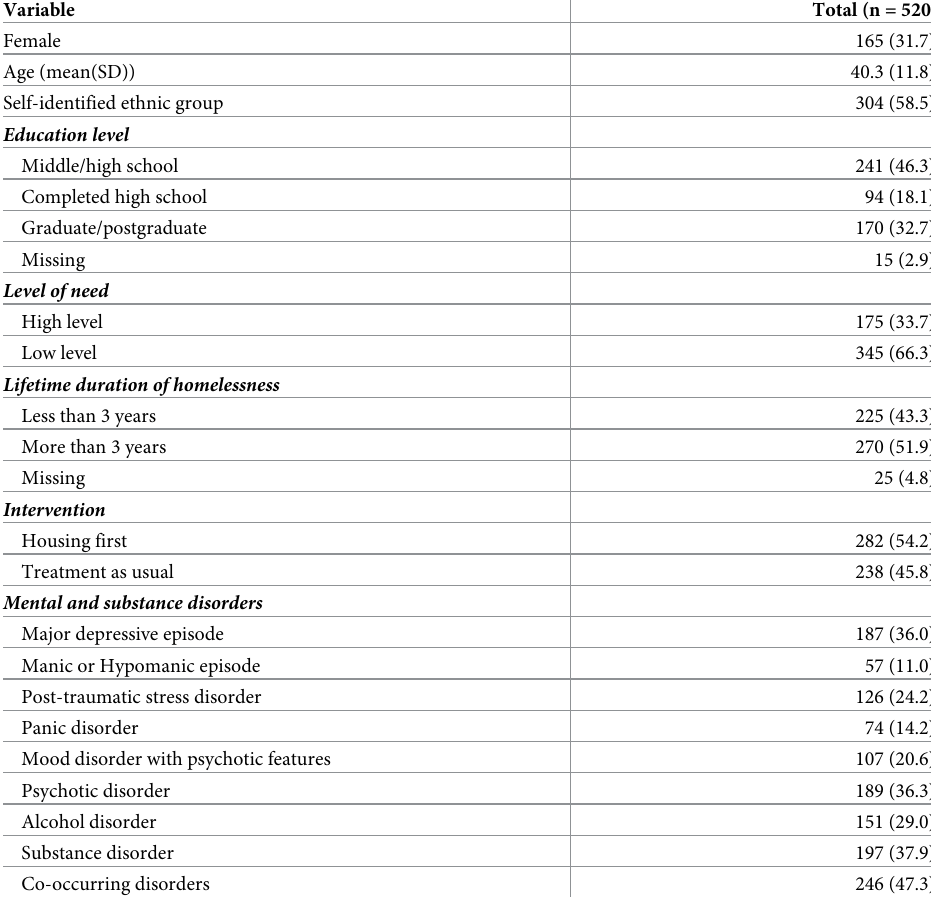
Table 1. Participants’ characteristics at